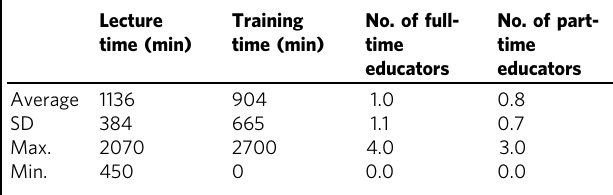
Table 2 Time of lectures and practical training in